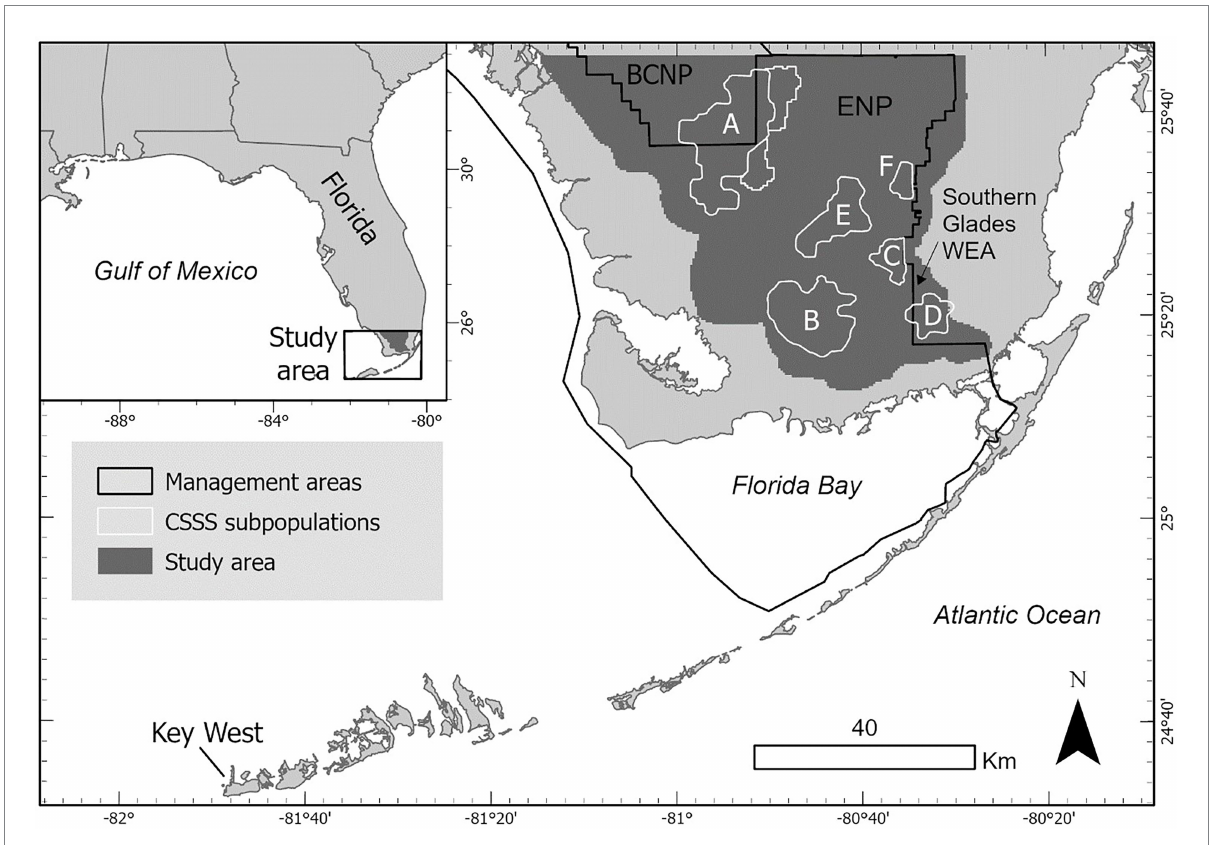
FIGURE 1 Map of the study area and overlap with management areas Everglades National Park (ENP), Big Cypress National Preserve (BCNP), and Southern Glades Wildlife and Environmental Area